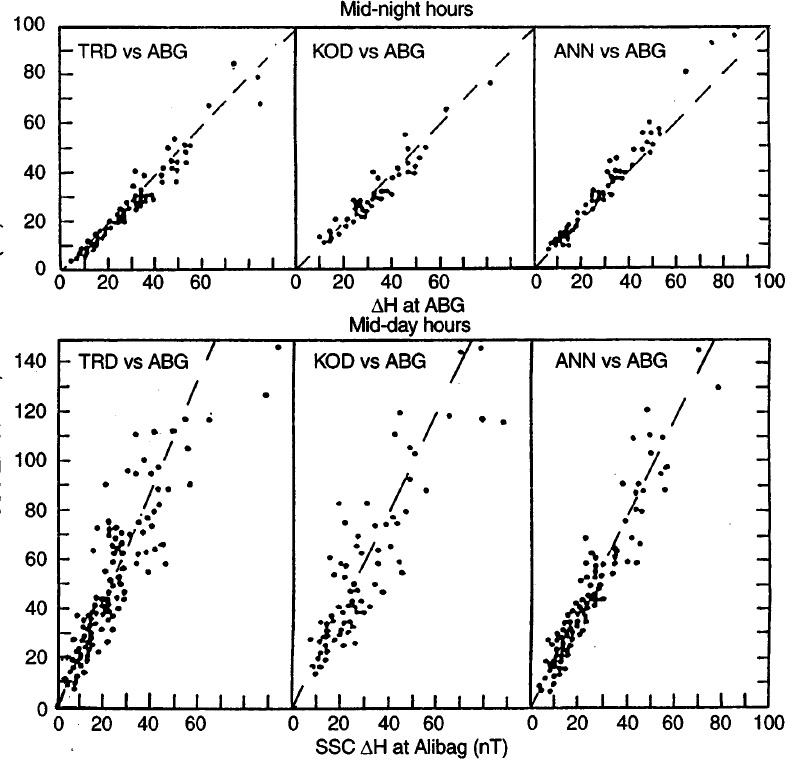
Fig. 6. Relationship between amplitudes in horizontal field H, at TRD , KOD , ANN and ABG of daytime and nighttime SSCs